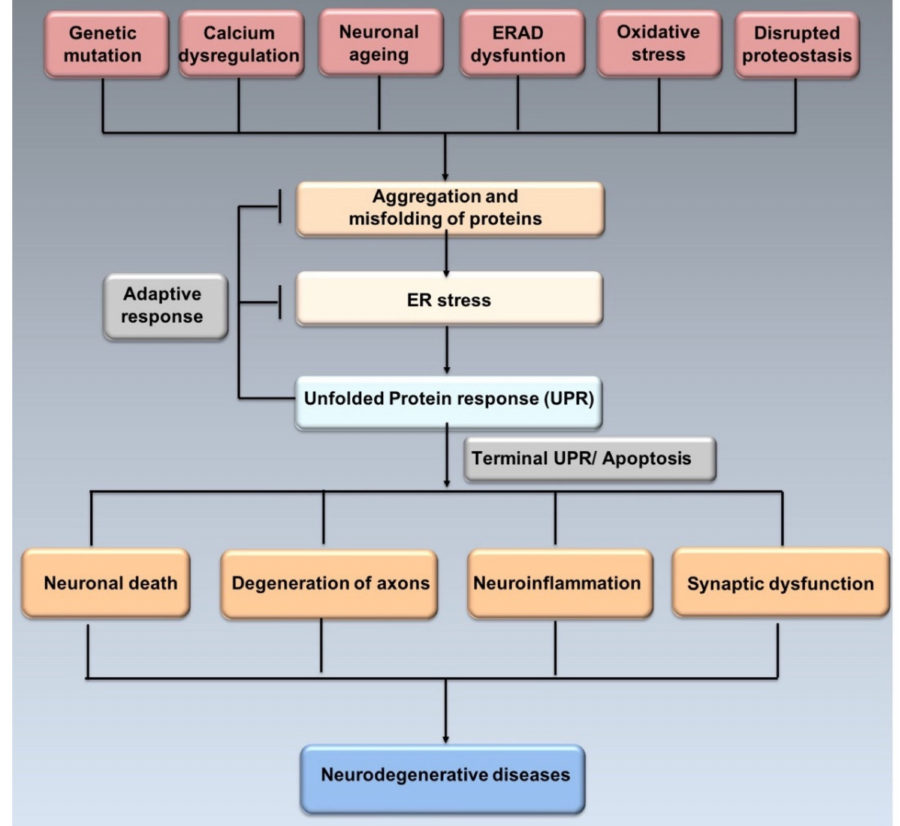
Figure 2. ER stress, UPR and neurodegeneration. Genetic mutations, ageing, oxidative stress, disrupted proteostasis and other stimuli may induce the misfolding and aggregation of proteins leading to ER stress. In order to resolve ER stress, adaptive response through UPR is activated. However, prolonged ER stress induces apoptosis a ff ecting neurons and synaptic funcion, thus leading to neurogenerative diseases (adapted from Hetz et al., 2017 [21]).